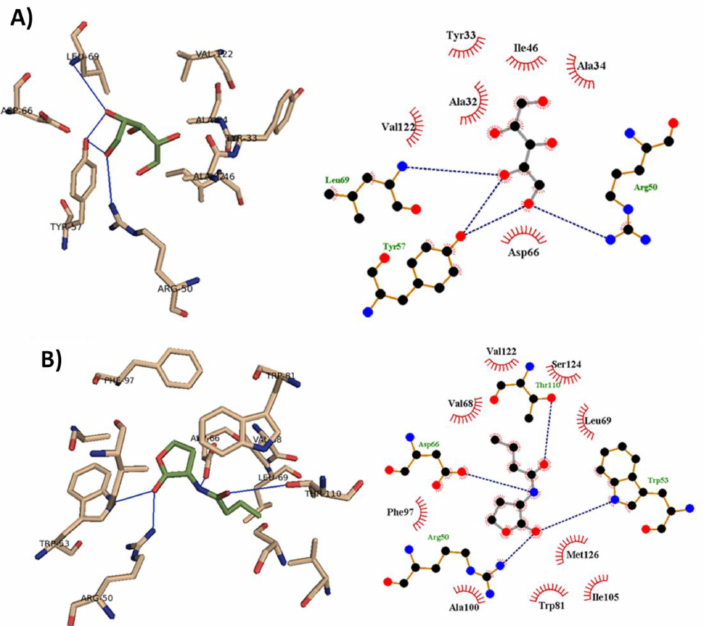
Figure 8. The Molecular docking of ( A ) Xylitol and ( B ) C4-HSL into the active site of SmaR protein 3D representation (left) and 2D Schematic interaction (right). Xylitol could bind with SmaR receptors by hydrogen bonding and hydrophobic